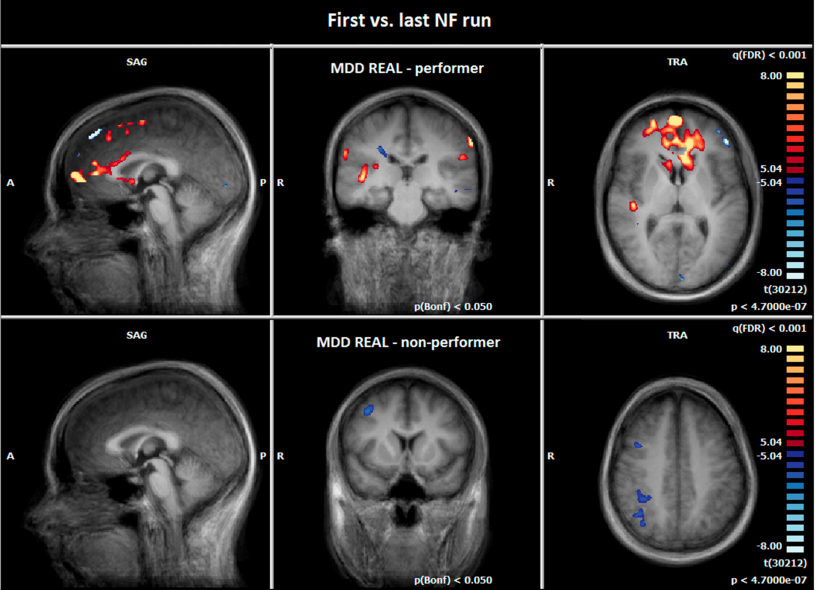
Figure 4. Hemodynamic responses of the first vs. last NF run (negative emotional pictures >